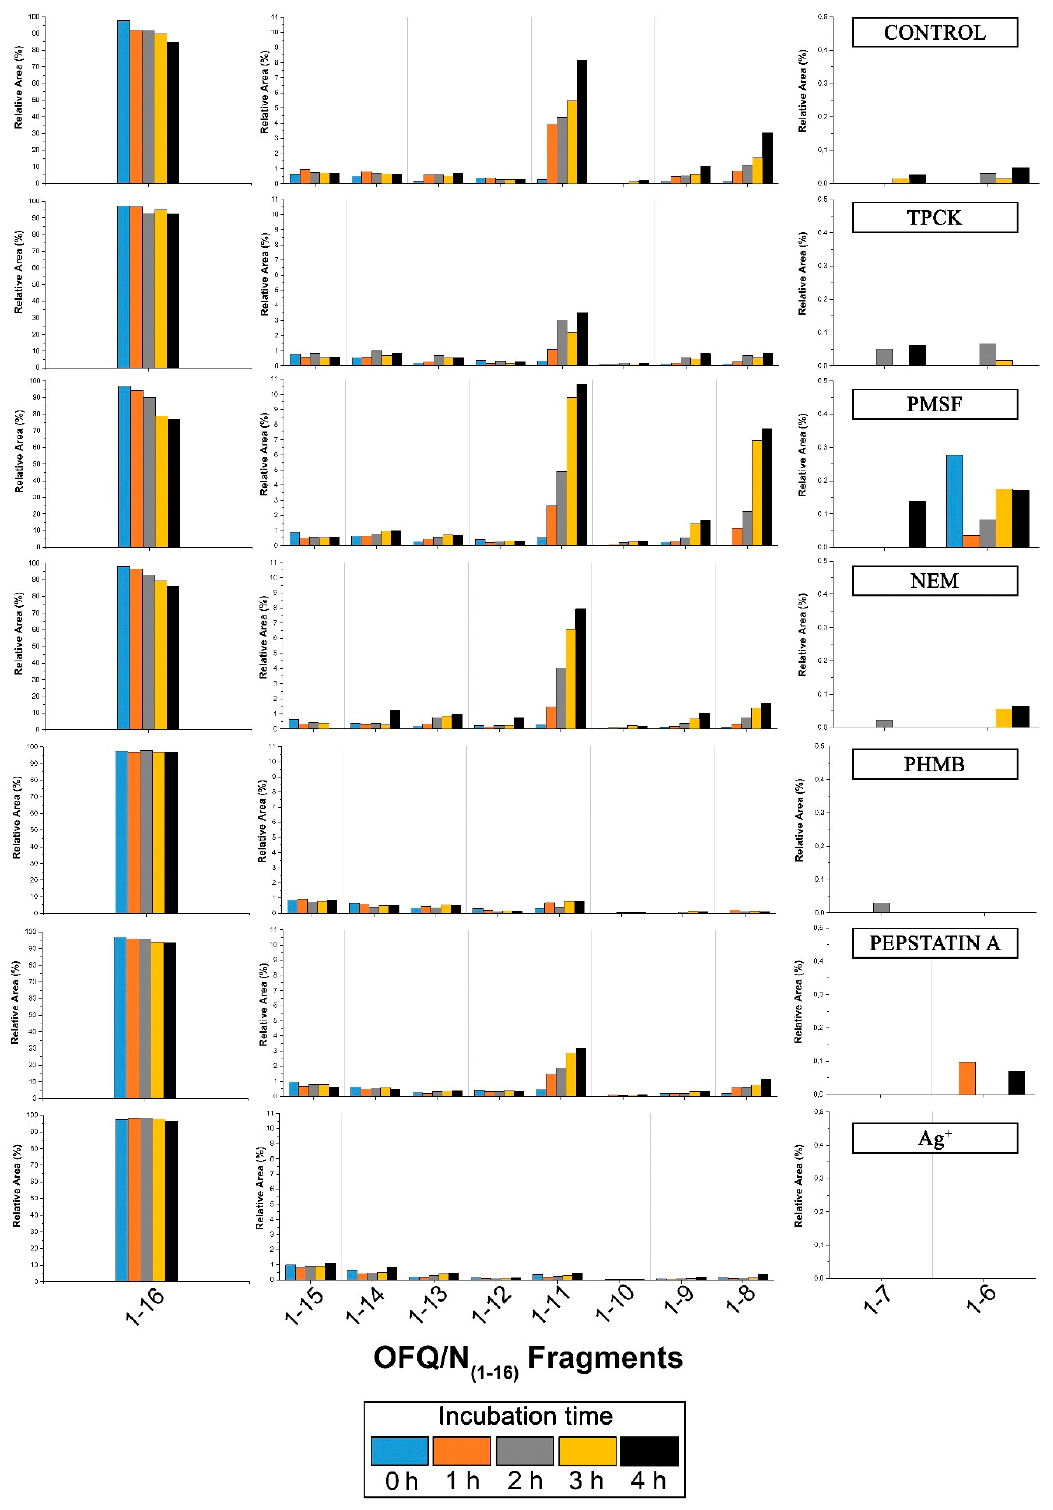
Figure 6. Time-course of the products after cleavage by rat spinal cord peptidases with the influence of different inhibitors on the metabolism. Bar graphs are relative to all the areas under the peaks detected by MALDI. On the left and on the right part of each histogram, relative areas of OFQ/N, fragments (1-7) and (1-6) are shown on a different scale due to the different values compared to all the other fragment areas.